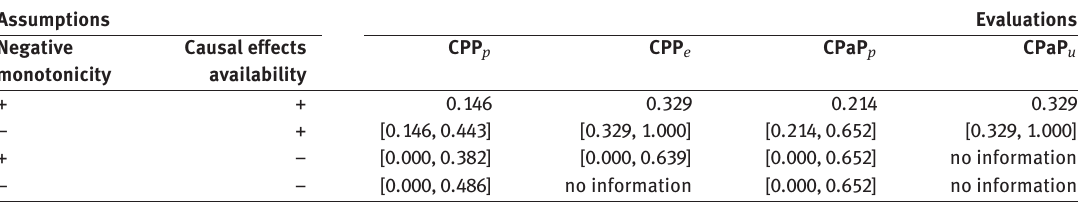
Table 4: Results from an example of the observational